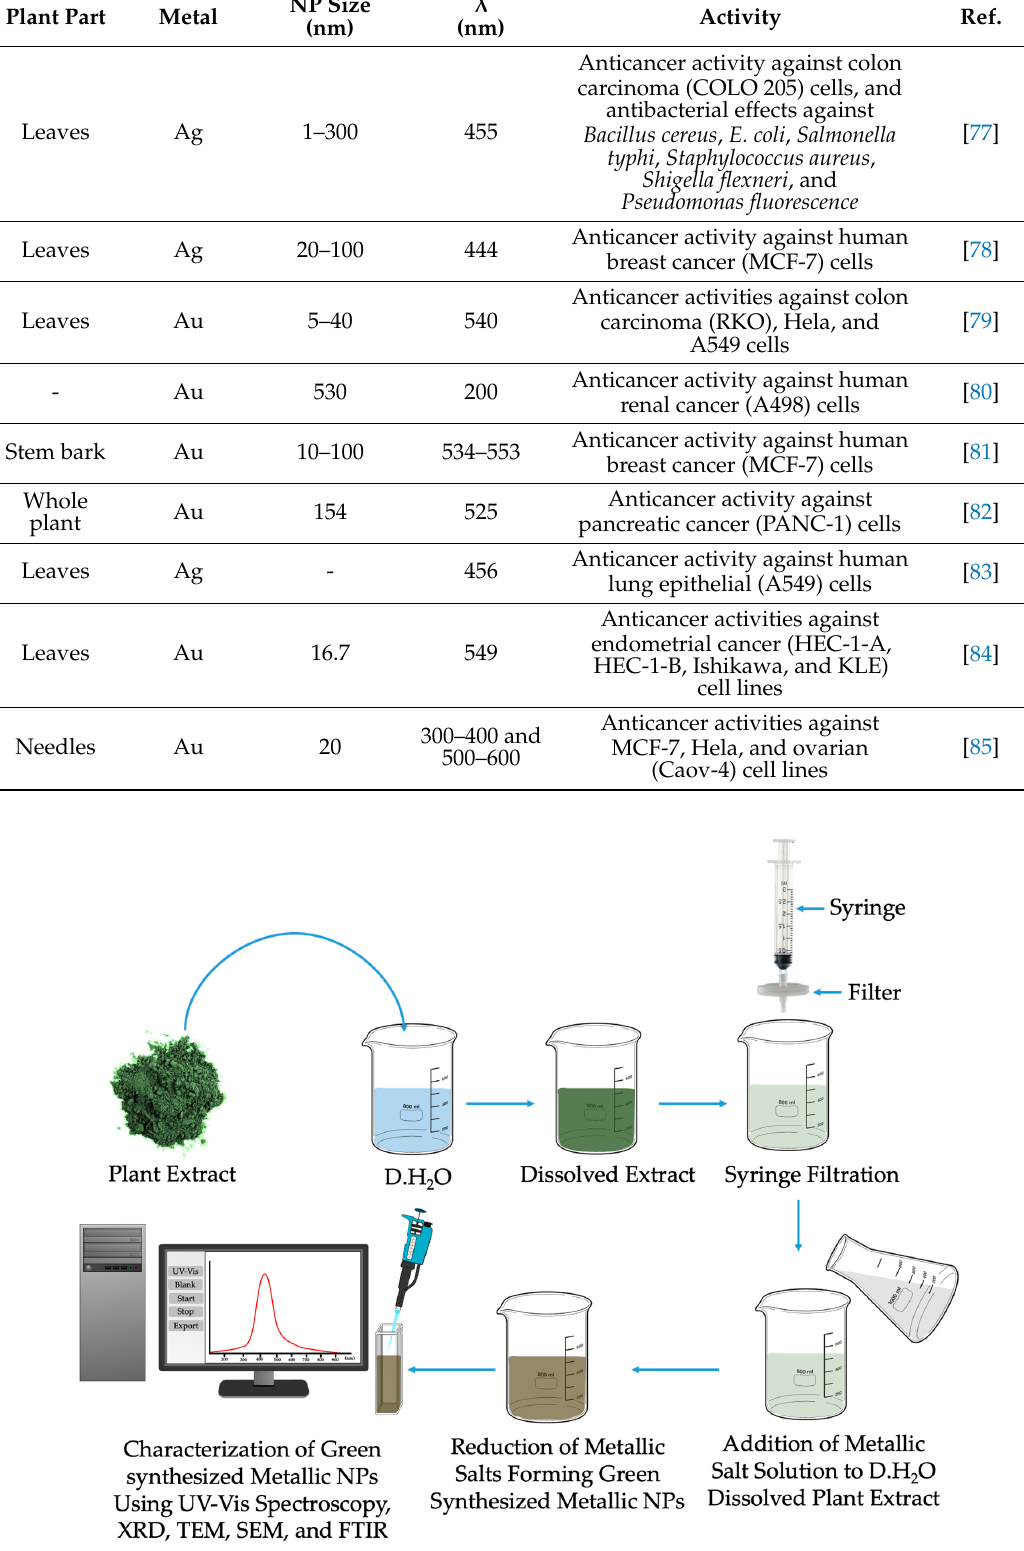
Figure 3. Schematic representation of the synthesis and characterization of green metallic nanopar- ticles. Table 4. Common medicinal plants used in the synthesis of metallic NPs for therapeutic use.